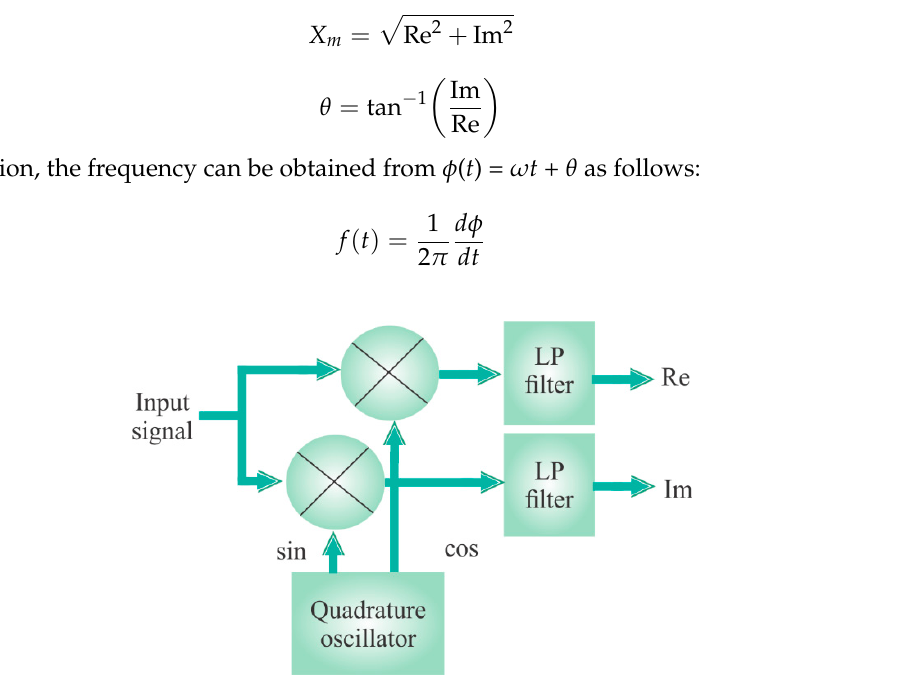
Figure 1. Phasor measurement model.